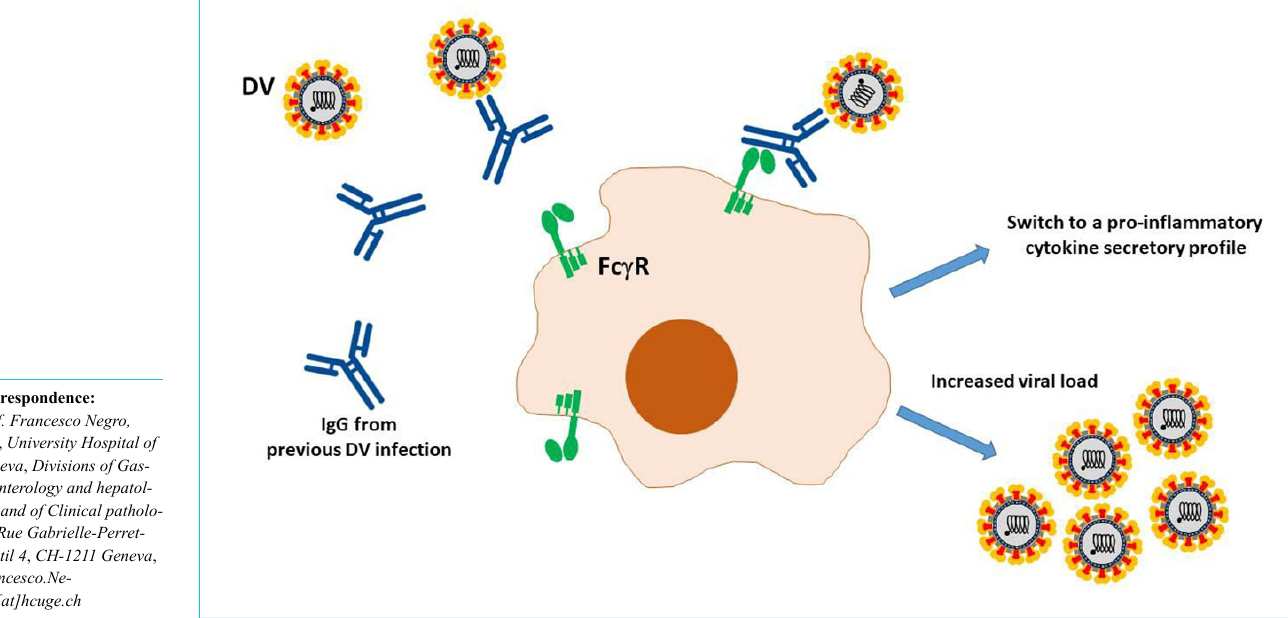
Figure 1: Schematic representation of antibody-dependent enhancement as reported for the Dengue virus (DV). Virions are recognised by heterotypic antibodies from a previous infection. Complexes bind then to the Fcγ receptor on the surface of macrophages, and internalized. DV replication leads to an increased viral load and a functional switch of macrophages towards a proinflammatory cytokine secretory